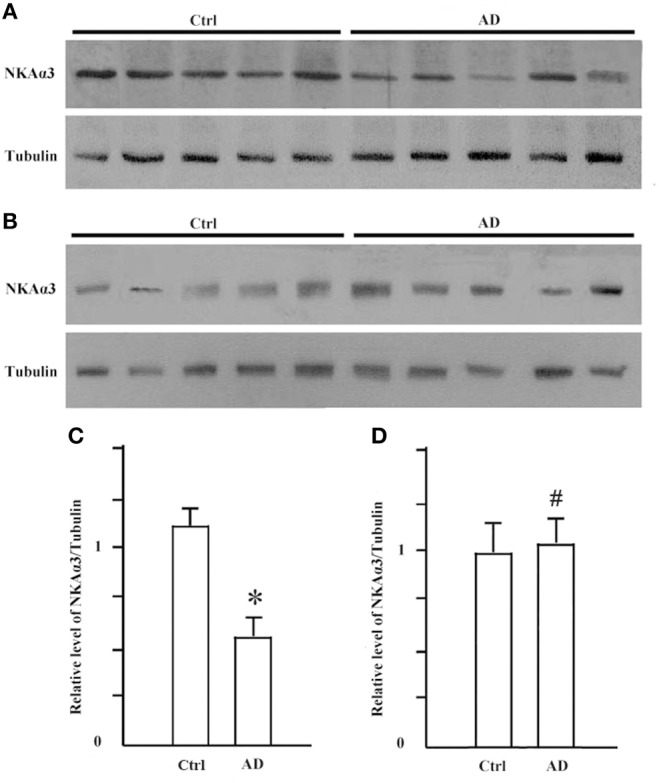
The levels of NKA α3 protein were decreased in PSD fractions of human AD cortex. Synaptosome and PSD fractions were prepared from 5 case human AD and 5 case control frontal cortical tissues. 20 μg proteins of each fraction were used for western blot. (A) NKA α3 proteins in PSD fractions were detected by western blot. (B) NKA α3 proteins in synaptosome fractions were detected by western blot. (C) Relative amount of NKA α3 proteins in control PSD at 1.10 ± 0.10 show decrease to 0.58 ± 0.09 in AD. Each value is expressed as mean ± SEM. n = 5, *p < 0.05. (D) Relative amount of NKA α3 proteins in synaptosome fractions show no significant difference. Each value is expressed as mean ± SEM. n = 5, #p > 0.05.